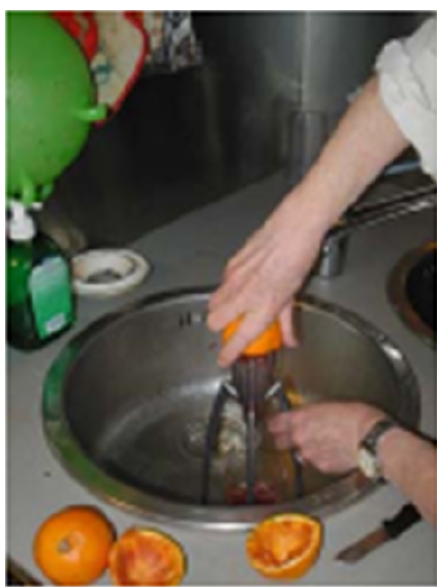
Fig. 1. Squeezing oranges in the